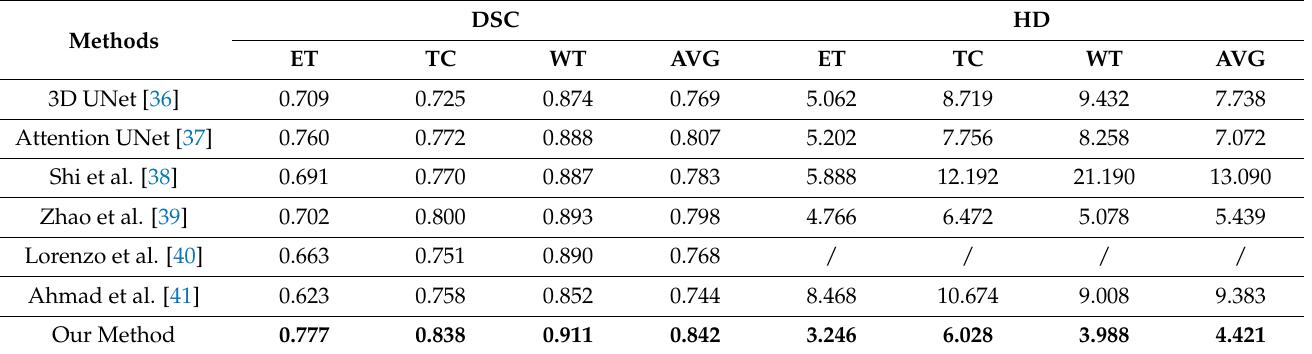
Table 3. Objective performance comparison with the state-of-the-art methods on the BraTS2019 validation dataset, in terms of their DSC and HD values. (Bold font indicates best results.)